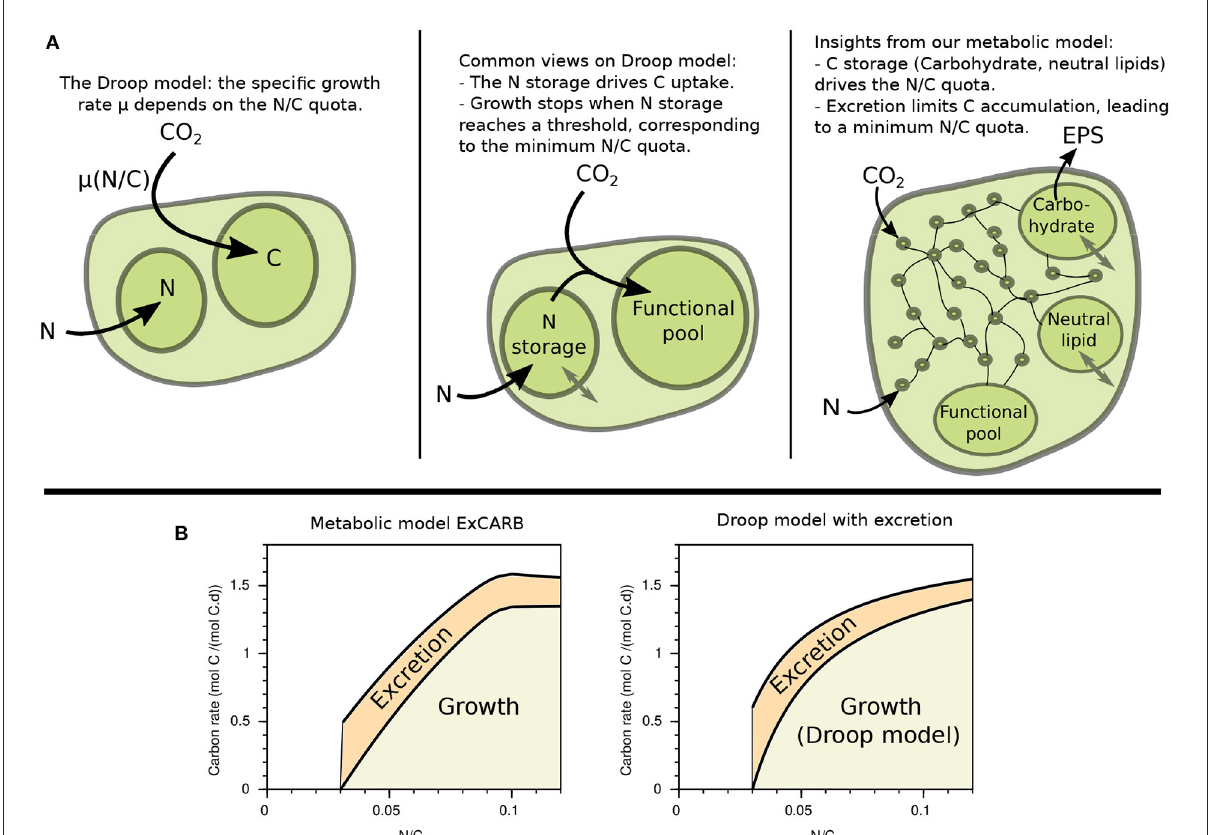
FIGURE8 Revisiting Droop model. (A) Illustrations of the empirical relationship (left) and common views (middle) on Droop model, in comparison with the insight from our metabolic model (right). (B) Growth and excretion rates as a function of the N/C quota given by the metabolic model ExCARB (left) and by the Droop model (2) with the additional equation (3)